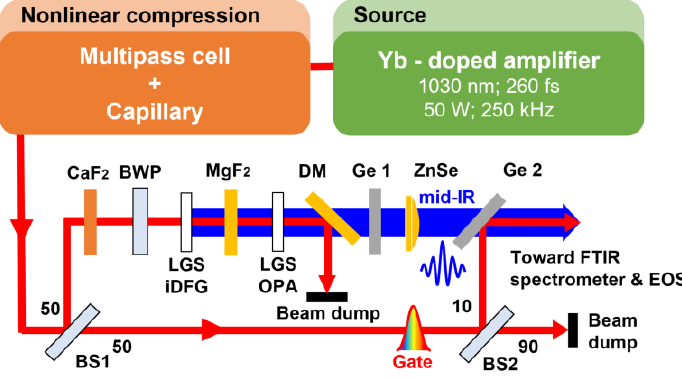
Fig. 1 Schematic of the experimental setup. The pump beam is sent on the 50/50 beamsplitter (BS1). The reflected driving pulses go through calcium fluoride (CaF2) windows to adjust the chirp and the bichromatic waveplate (BWP). Then, they drive the generation in the